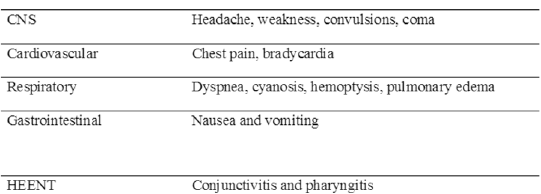
Table 1 Clinical Characteristics of acute hydrogen sulfide poison‑ ing